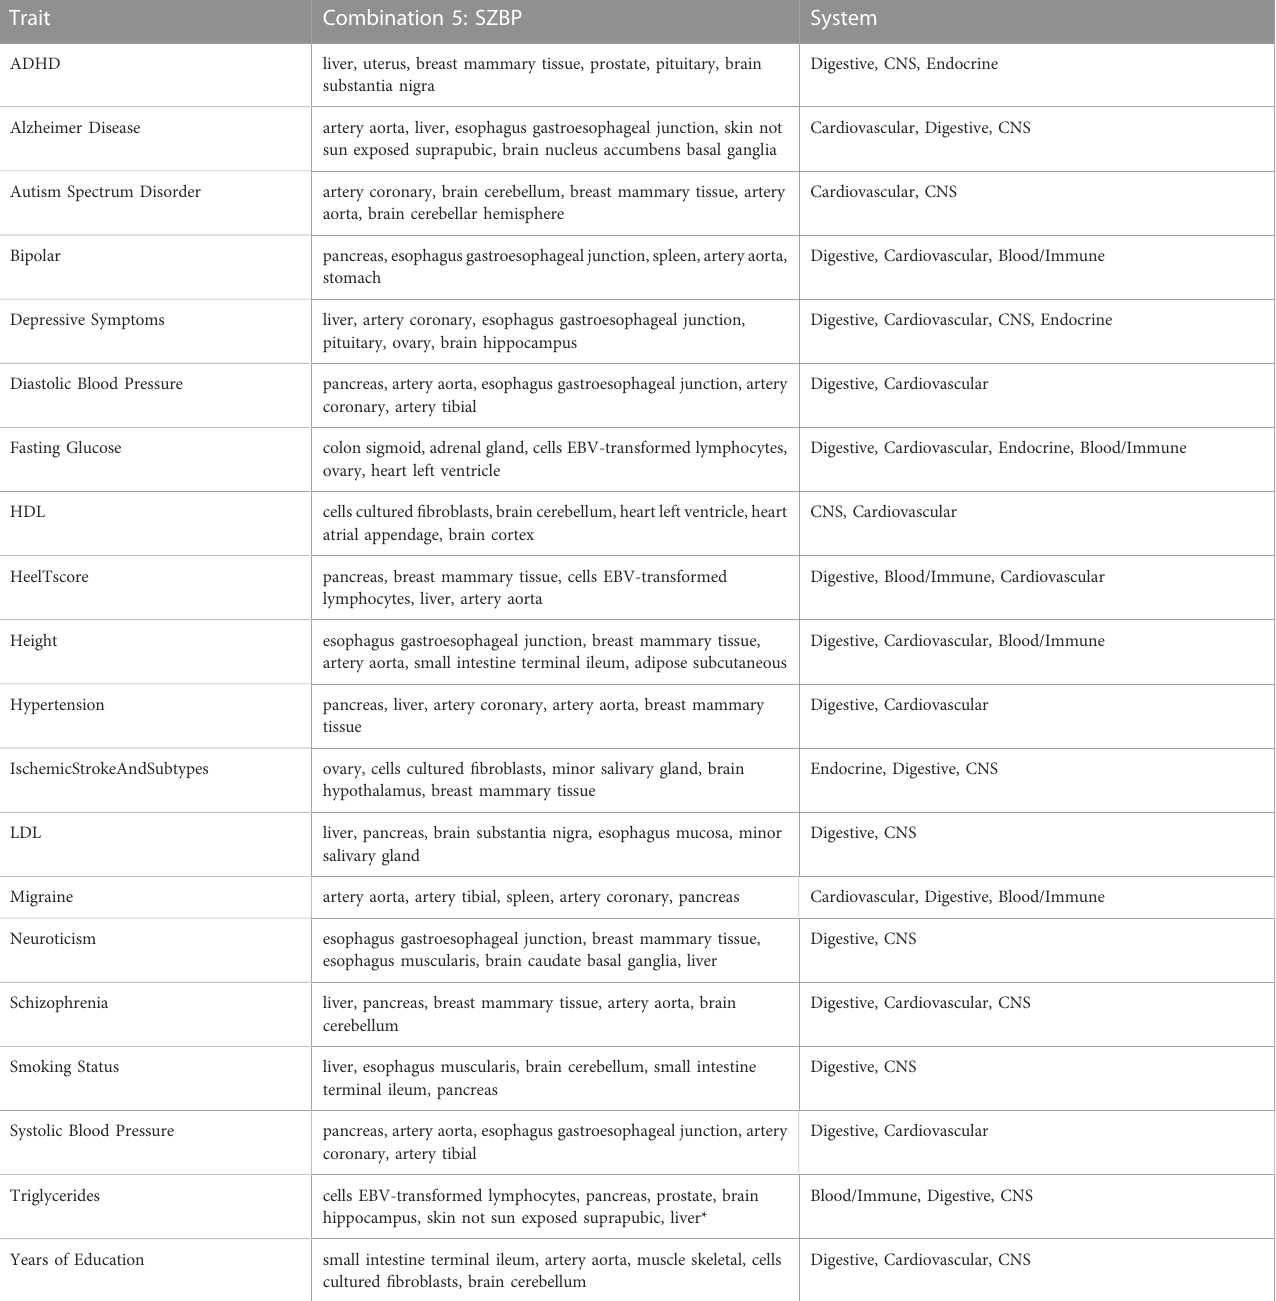
TABLE 4 The top 10% of tissues prioritised as having candidate causal regulatory effects for the test datasets. Trait Combination 5: